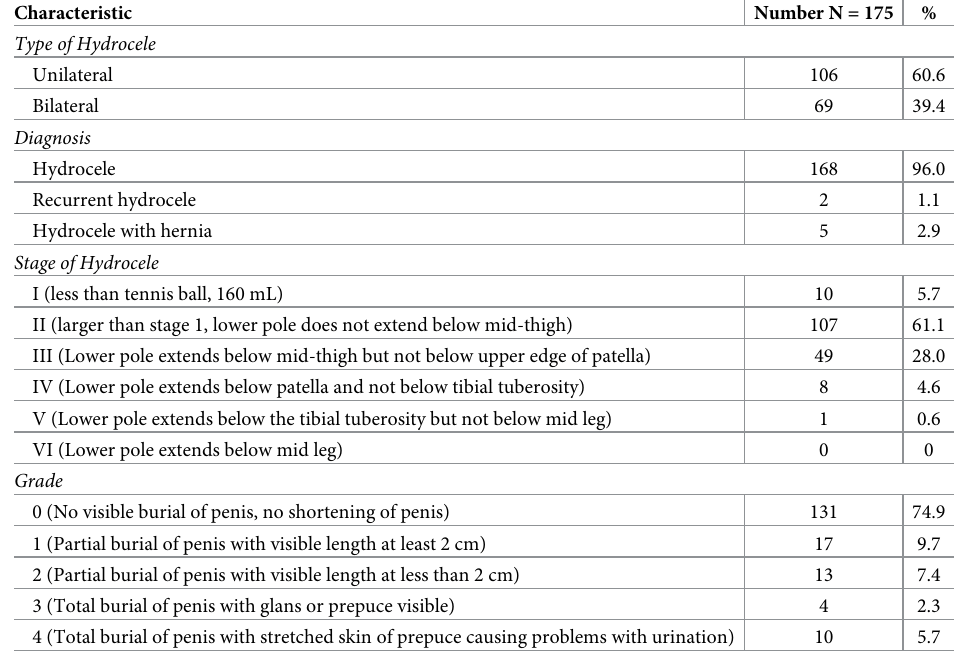
Table 1. Characteristics of operated patients by type and stage of